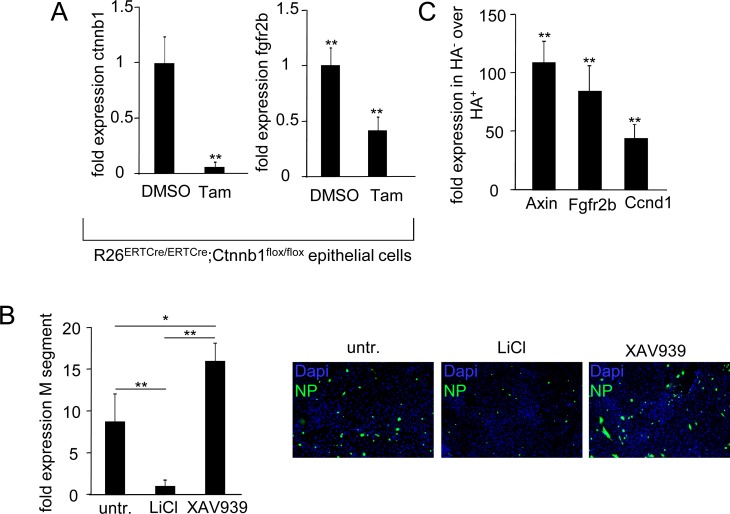
β-catenin dependent transcription mediates upregulation of Fgfr2b expression, which is inhibited in PR/8-infected, but not in non-infected lung epithelial cells.(A) EpCam+ lung epithelial cells derived from Rosa26
ERTCre/ERTCre
;Ctnnb1
flox/flox mice were grown to confluency and treated with tamoxifen or DMSO control prior to infection with PR/8 (MOI = 0.1; 24h). mRNA expression of β-catenin (Ctnnb1) (left) or of Fgfr2b (right) was quantified and normalized to values of DMSO-treated control. (B) Wt distal lung epithelial cells in confluent culture were PR/8-infected (MOI 0.1) and treated with an activator (LiCl) or inhibitor (XAV939) of β-catenin signaling. Expression of the viral M segment was quantified at 16 h pi and normalized to LiCl-treated cultures (left). The right plot shows representative photomicrographs of these cultures stained for IV nucleoprotein (NP) after 6 h of PR/8 infection. (C) Wt mice were infected with PR/8 for 7d and infected (IV hemagglutinin+, HA+) vs. non-infected (HA-) EpCam+ cells were flow-sorted. Expression of the β-catenin-dependent transcripts Axin2, Fgfr2b, and Ccnd1 was quantified in HA- cells and normalized to values from HA+ cells. All bar graphs represent means ± SD of n = 3–4 independent experiments; * p<0.05; **p<0.01; Tam, tamoxifen.